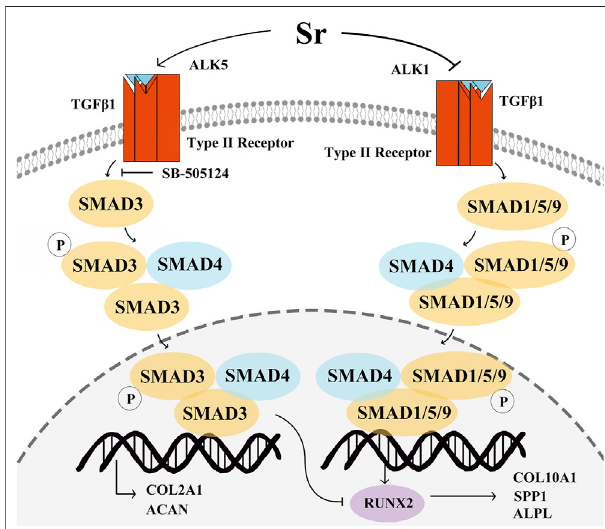
FIGURE 7 | Schematic of the proposed mechanism whereby Sr affects proliferation and differentiation of bovine chondrocytes via the transforming growth factor β (TGF β ) signaling pathway. Sr shifts the signaling of TGF β 1 to SMAD family member 3 (SMAD3) by promoting activin receptor-like kinase 5 (ALK5) expression and inhibiting ALK1 expression. Phosphorylation of SMAD3 and SMAD1/5/9 after binding with SMAD4 transfers them into the nucleus to regulate gene transcription. An increase in pSMAD3 promotes the expression of type Ⅱ Collagen α 1 (COL2A1) and aggrecan (ACAN). pSMAD1/ 5/9 induces type Ⅹ Collagen α 1 (COL10A1), secreted phosphoprotein 1 (SPP1),vascularendothelialgrowthfactor (VEGFA),and alkalinephosphatase (ALPL) by stimulating the function of runt-related transcription factor 2 (RUNX2). The increase in the pSMAD3 can inhibit the function of RUNX2 to decrease the COL10A1, SPP1, and ALPL